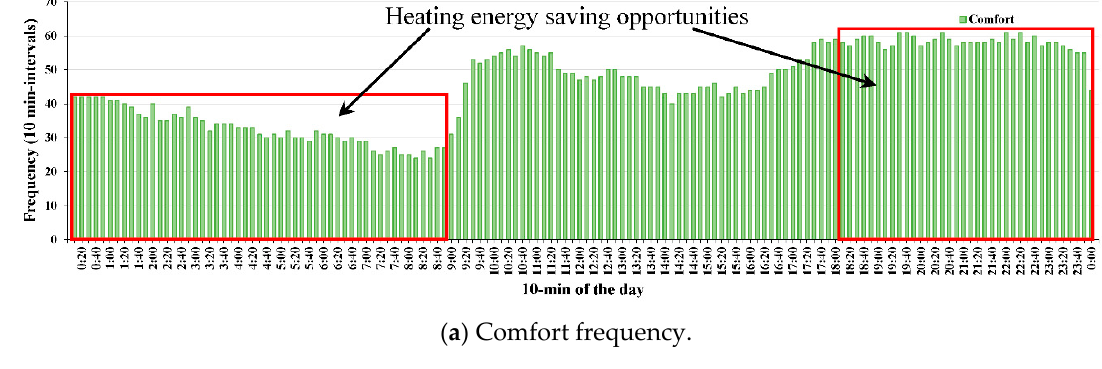
Figure 5. Graphical comfort zone analysis. RH, relative humidity.